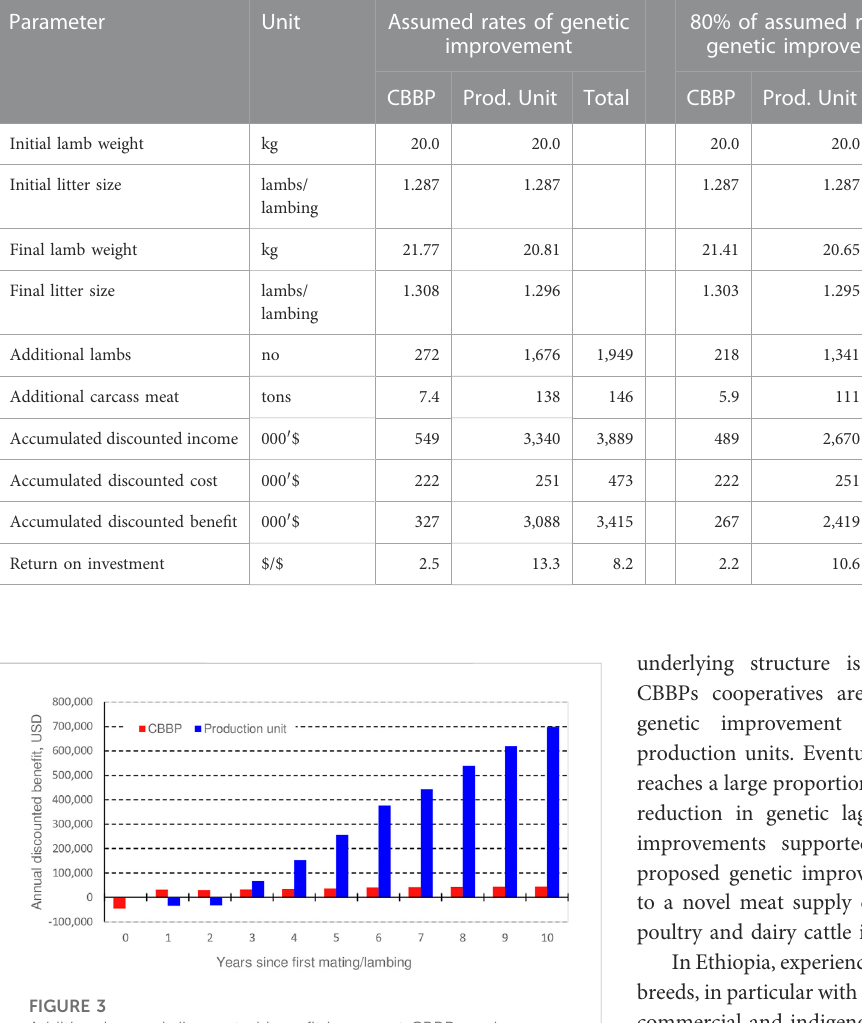
TABLE4PredictedgeneticmeritinCBBPandclientproductionunitsafter10 yearsofselectionforsimultaneousimprovementoflambweightandlittersizeandits effect on additional meat production and economic bene fi t. Assumed rates of genetic improvement in lamb weight and litter size are those observed in Horro sheep CBBPs.